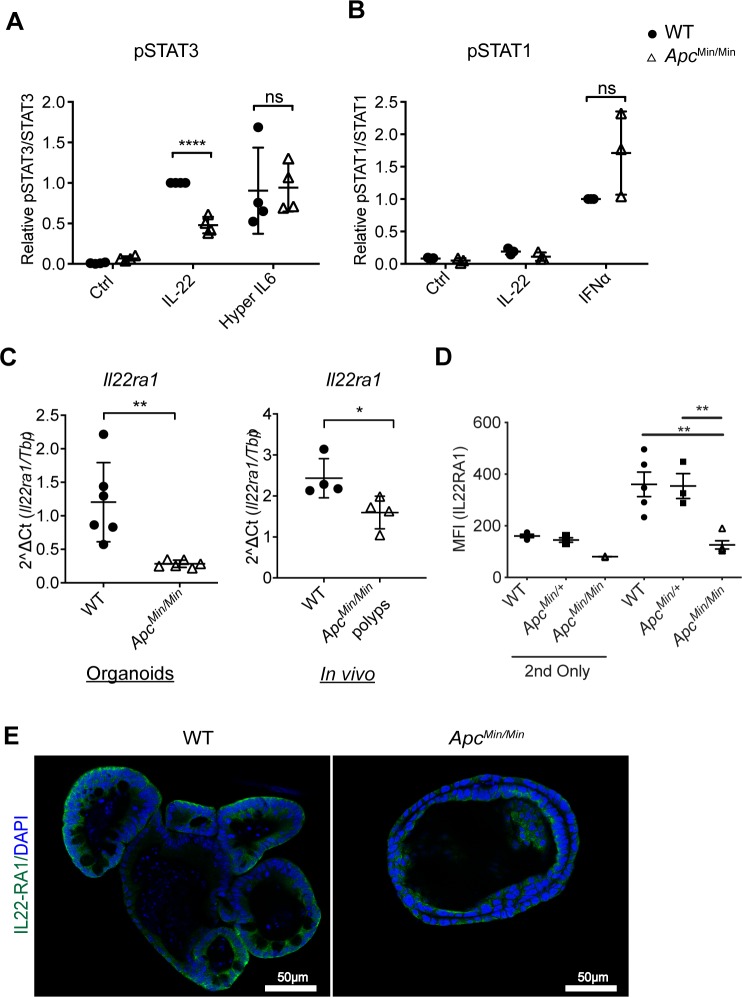
ApcMin/Min organoids lose expression of the IL-22 receptor.(A) Amount of pSTAT3 (Tyr705)/STAT3 in WT and ApcMin/Min organoids stimulated with IL-22 (10 ng/ml) or hyper IL-6 (50 μM) for 0.5 hours, normalised to that in WT treated with IL-22 in each experiment. **p < 0.01, paired t test. (B) pSTAT1 (Tyr701)/STAT1 in WT and ApcMin/Min organoids untreated or stimulated with IL-22 or IFNα (1,000 U/ml) for 0.5 hours, normalised to that in WT cells treated with IFNα in each experiment. (C) RT-qPCR analysis of Il22ra1 expression in WT and ApcMin/Min organoids, and in tissue biopsies (in vivo) from WT intestines or polyps from ApcMin/+ mice. Organoids, n = 6, tissue, n = 3. *p < 0.05, two-tailed t test. (D) WT, ApcMin/+, or ApcMin/Min organoids were dissociated, and IL22RA1 expression was measured by flow cytometry. MFI of IL22RA1 staining from 3 biological replicates is plotted. “2nd only” reflects samples that were stained only with secondary antibody (i.e., not exposed to primary antibodies). **p < 0.01 on one-way ANOVA. (D) WT and ApcMin/Min organoids were fixed and immunostained with IL22RA1 antibodies (green), and nuclei were stained with Hoechst (blue). Numerical values for (A), (B), (C), and (D) are available in S1 Data. Apc, adenomatous polyposis coli; IFN, interferon; IL-22, interleukin-22; IL22RA1, interleukin 22 receptor subunit alpha 1; MFI, mean fluorescence intensity; pSTAT3, phosphorylated STAT3; STAT1/3, signal transducer and activator of transcription 1/3; Tyr705, Tyrosine 705; RT-qPCR, quantitative reverse transcription polymerase chain reaction; WT, wild-type.